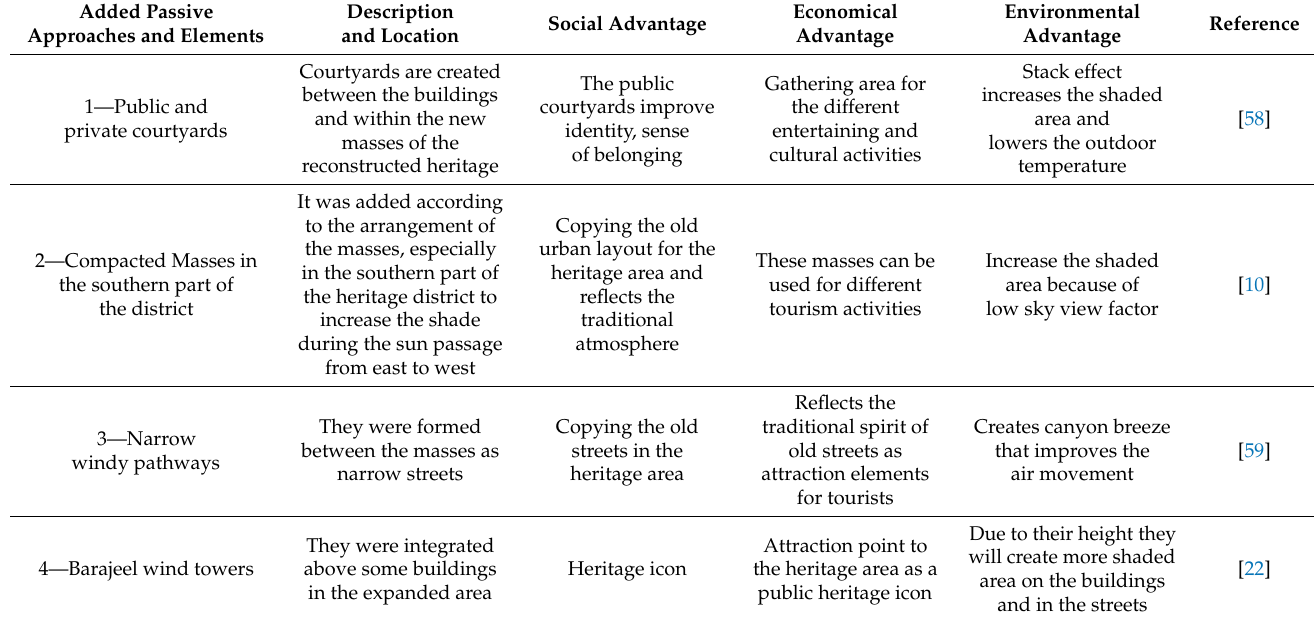
Table 3. Passive approaches and elements for the suggested outline for the development of the Ajman heritage